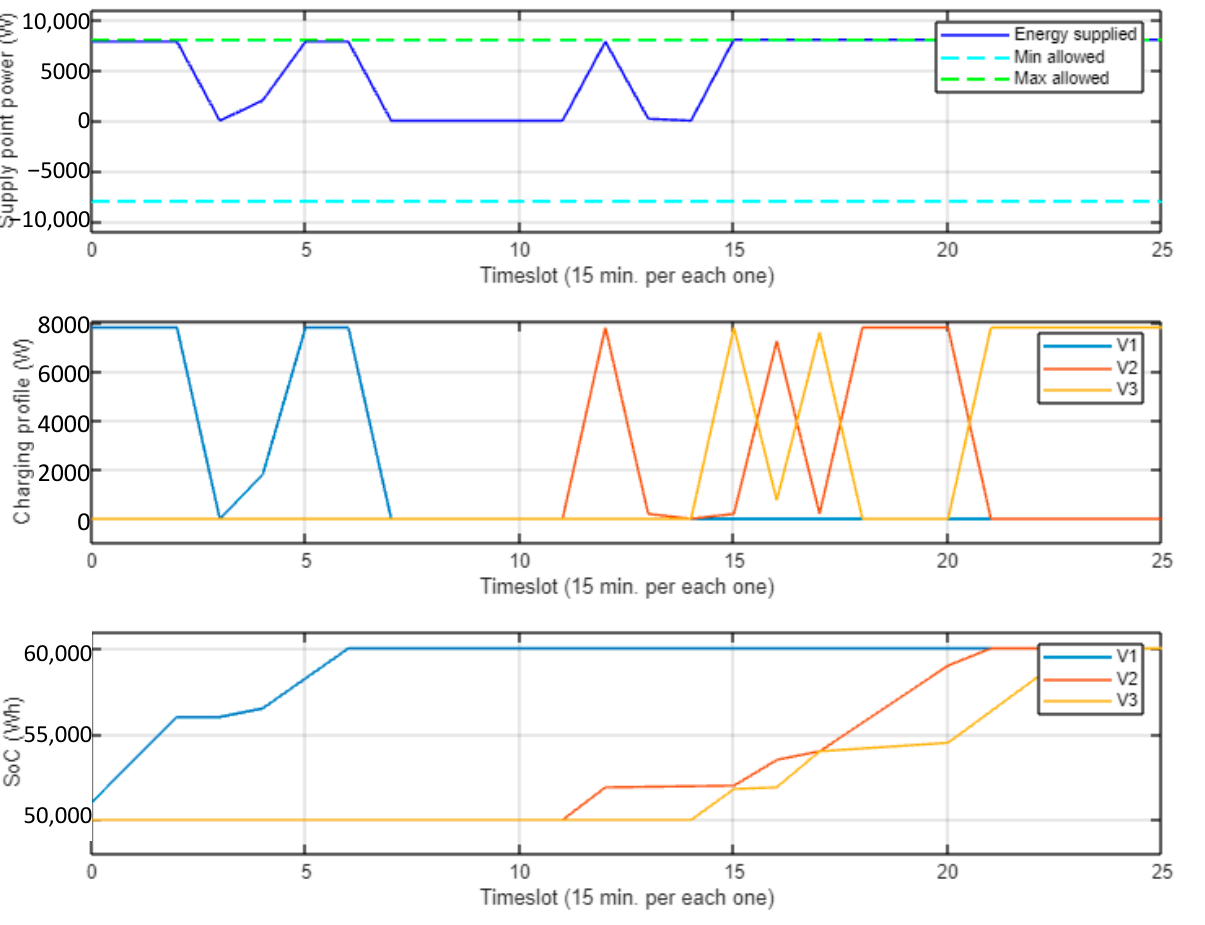
Figure 12. SCT output considering energy prices.